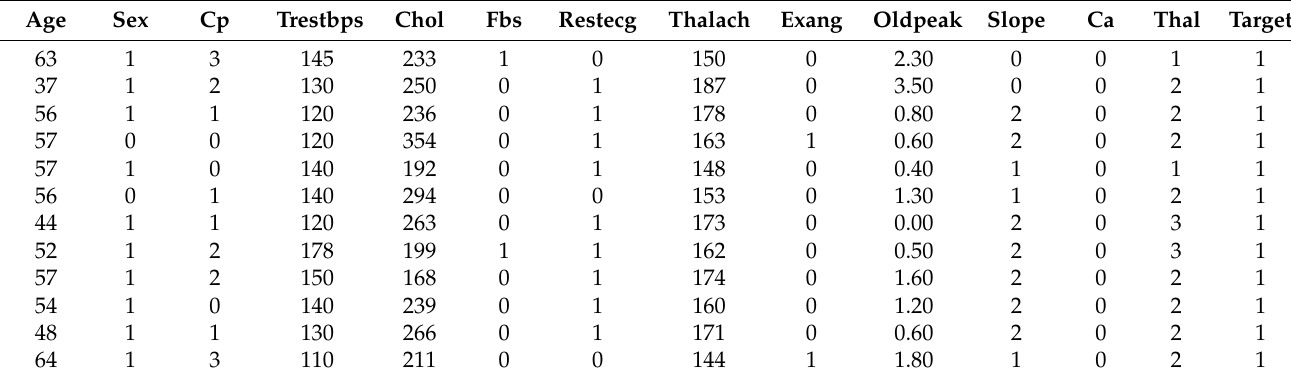
Table 3. Second set of